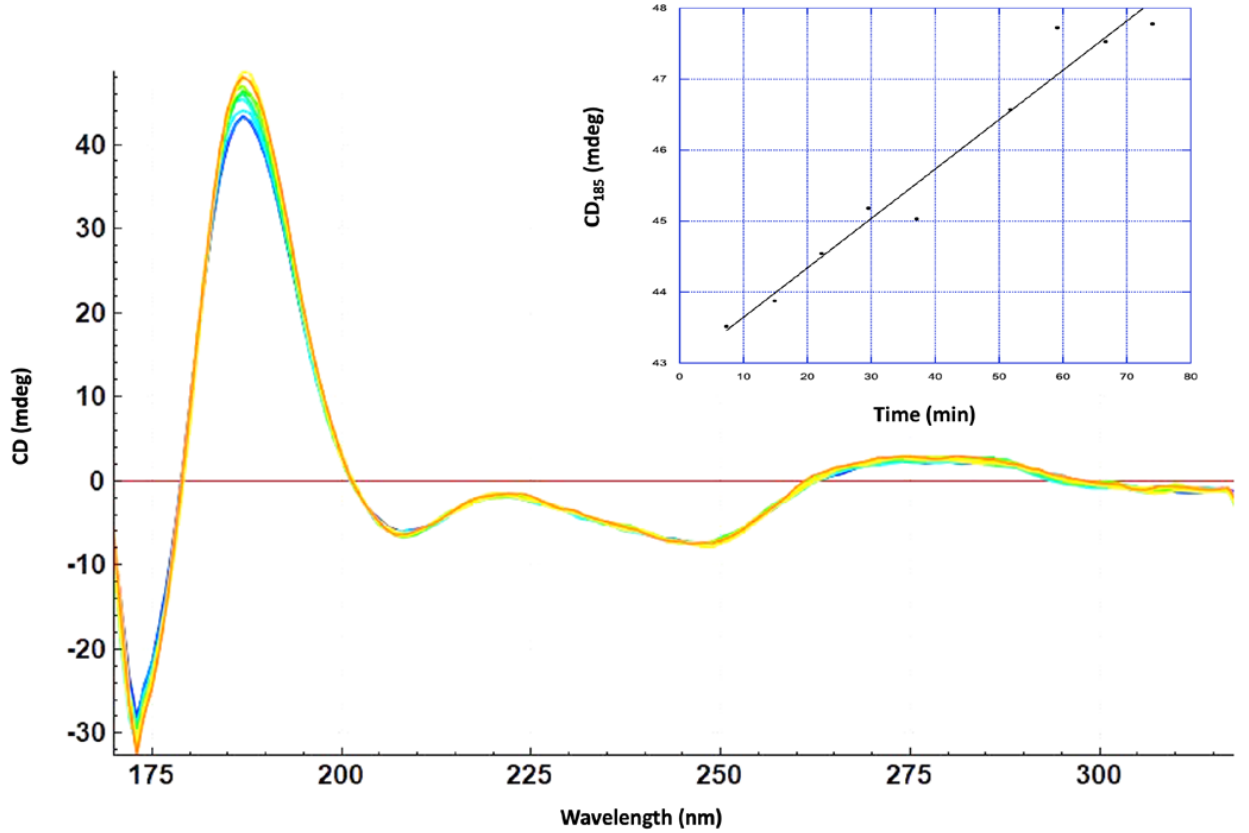
Figure 10. Hfq-CTR does not melt the C-stretch region of ColE1 plasmid DNA. Rather, Hfq-CTR appears to stabilize the dsDNA structure. Spectra of the kinetics are from blue (taken 2 min after the addition of the CTR) to red (80 min after the addition of the CTR). This can be observed by the evolution of the spectra, mainly at 185 nm. Inset: kinetics of annealing at 185 nm. Kinetic constants k catapp is 0.069 mdeg.M −1 .min −1 . This indicates that Hfq-CTR stabilizes the dsDNA, as confirmed be- low (see Figure 11). Note that we suspect that the effect could be quasi-instantaneous after binding but cannot be analyzed during the first seconds of the kinetics due to deadtime to load the cell.